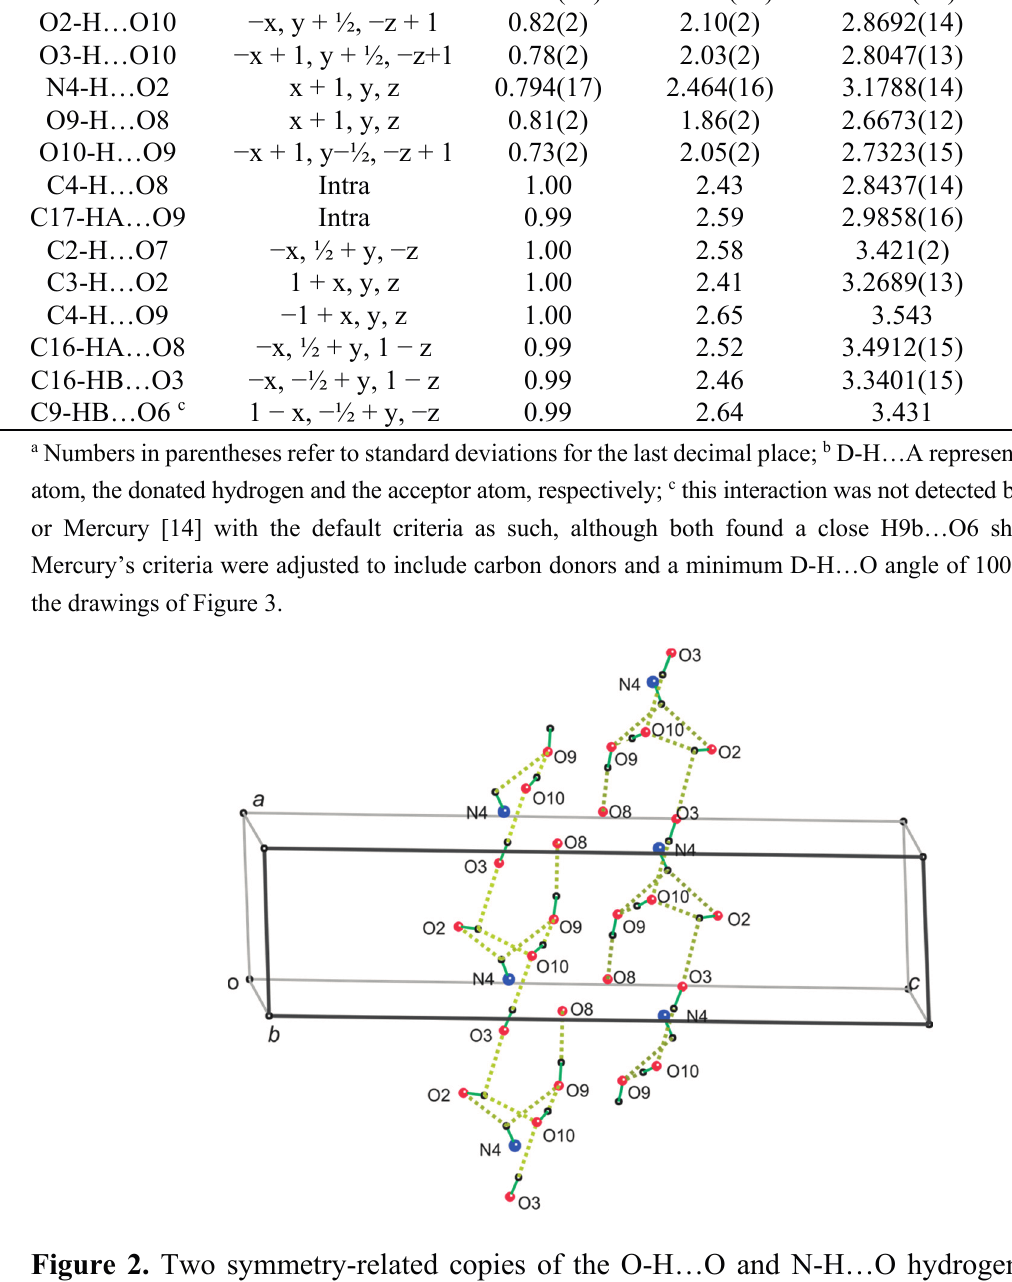
Figure 2. Two symmetry-related copies of the O-H…O and N-H…O hydrogen bonding network with the unit cell (One symmetry axis of this cell is coincident with the b -axis, and the other is parallel, but intersects the a – c plane at its center. The rings of the hydrogen bonds consist of N4-H, O2, O2-H, O10, O10-H and O9; infinite chains consist of O3, O3-H, O10, O2 and O2-H, which donates to O3, beginning the next repeat unit. The rings depend on N4 as a double donor and O9 as a double acceptor. In the infinite chains, O10 is a double acceptor. The strongest hydrogen bond is from O9-H to carbonyl oxygen atom O8. See Table 2 for the geometric